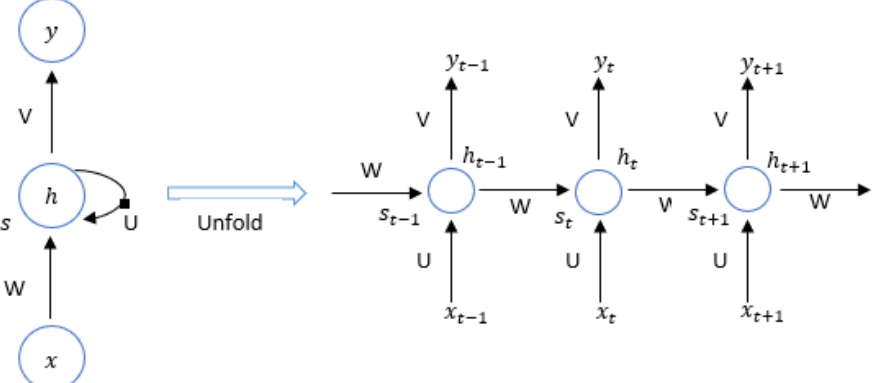
Figure 7. The expanded form of a recurrent neural network.